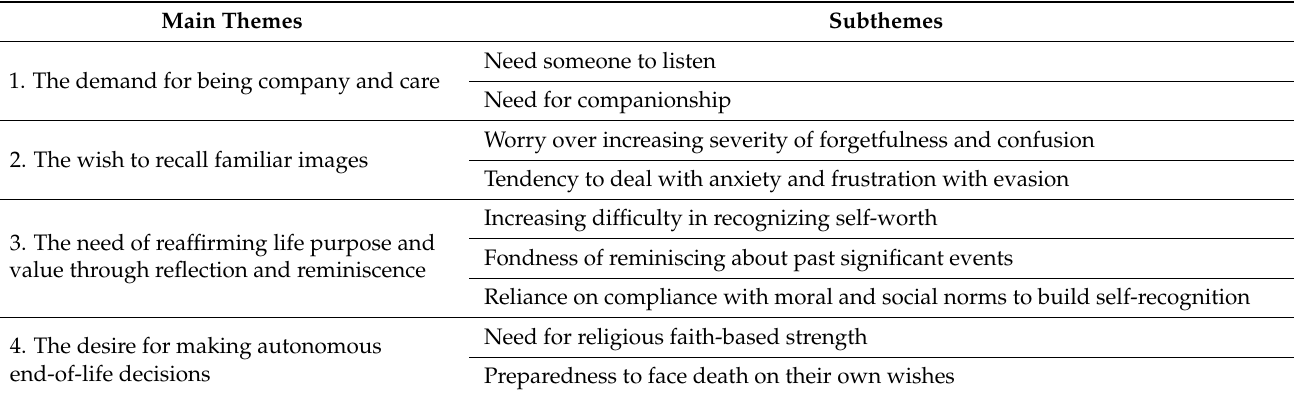
Table 2. The needs of participants living with moderate